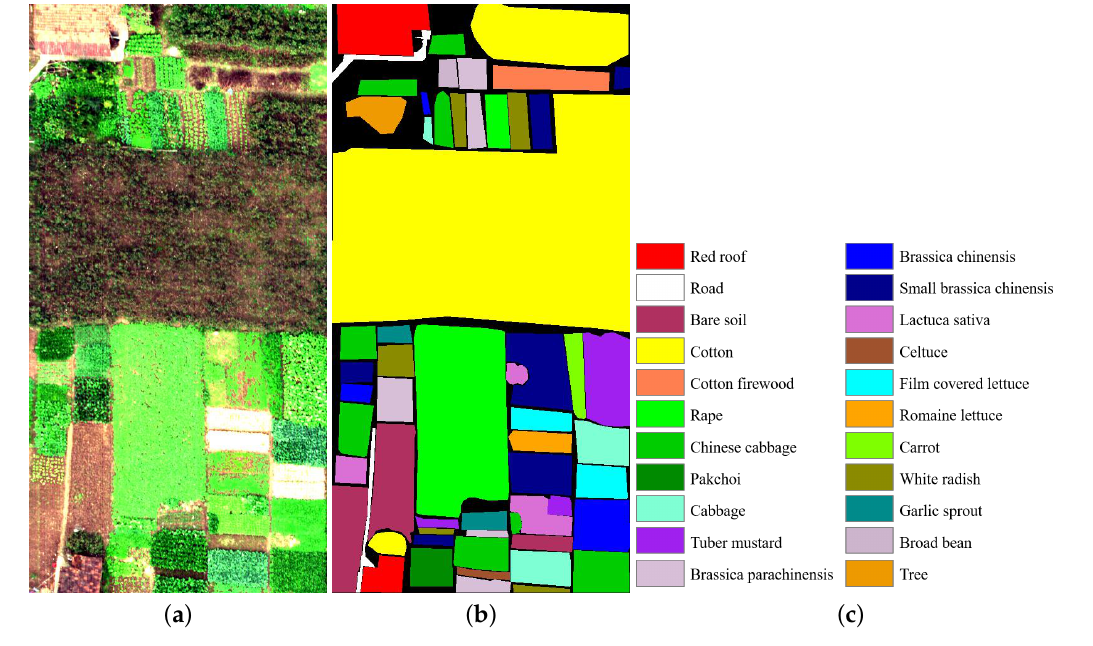
Figure 4. Honghu dataset. ( a ) False color composite. ( b ) Reference image. ( c ) Label name.